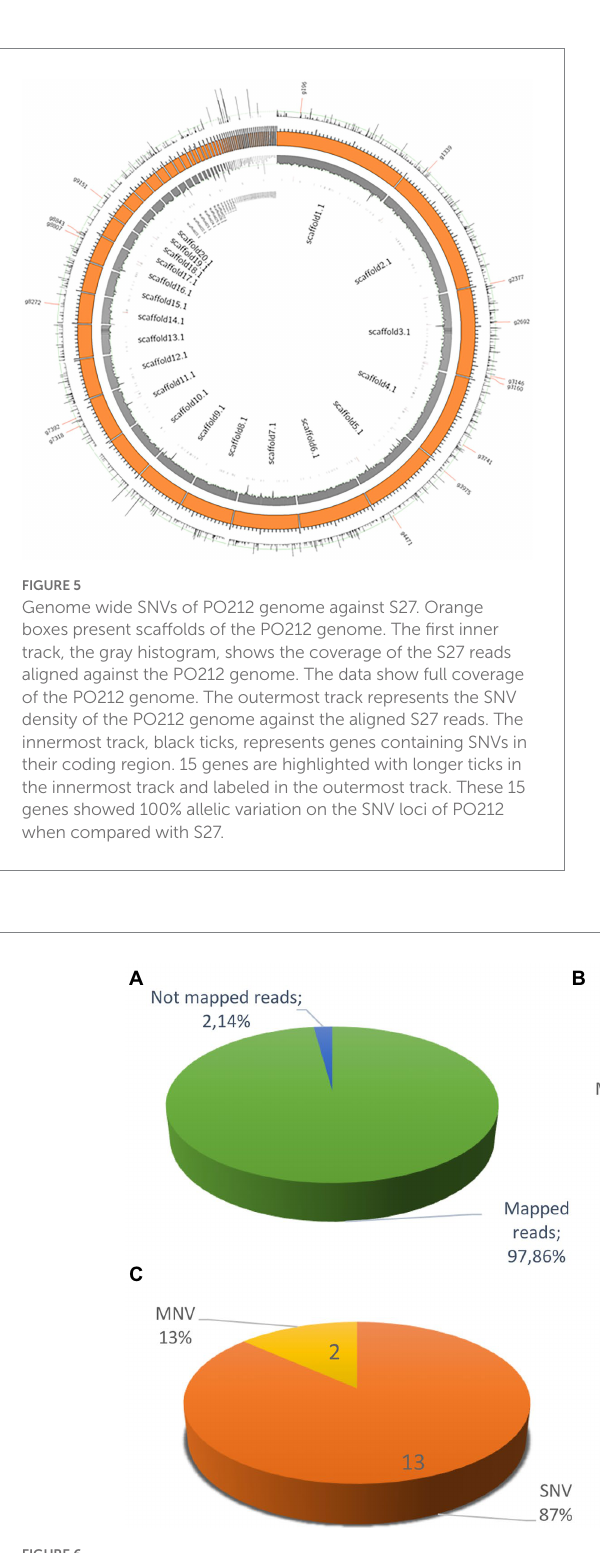
FIGURE 6 Variations between Penicillium rubens strains 212 (PO212) and S27 genomes. (A) S27 mapped reads vs. the un-mapped reads using PO212 as a reference genome. (B) Differences between two strains classified according the type of mutation: 71 SNVs, 7 MNVs, 14 Insertions, 9 Deletions, and 3 Replacements. (C) Differences between the two strains in the coding regions with 100% of frequency: 13 SNVs and 2 MNVs. After a review with preliminary RNA-Seq data support, we discarded seven variations, considered them as mistakes, and classified two as silent variations, since they did not cause an amino acid change (Supplementary Table